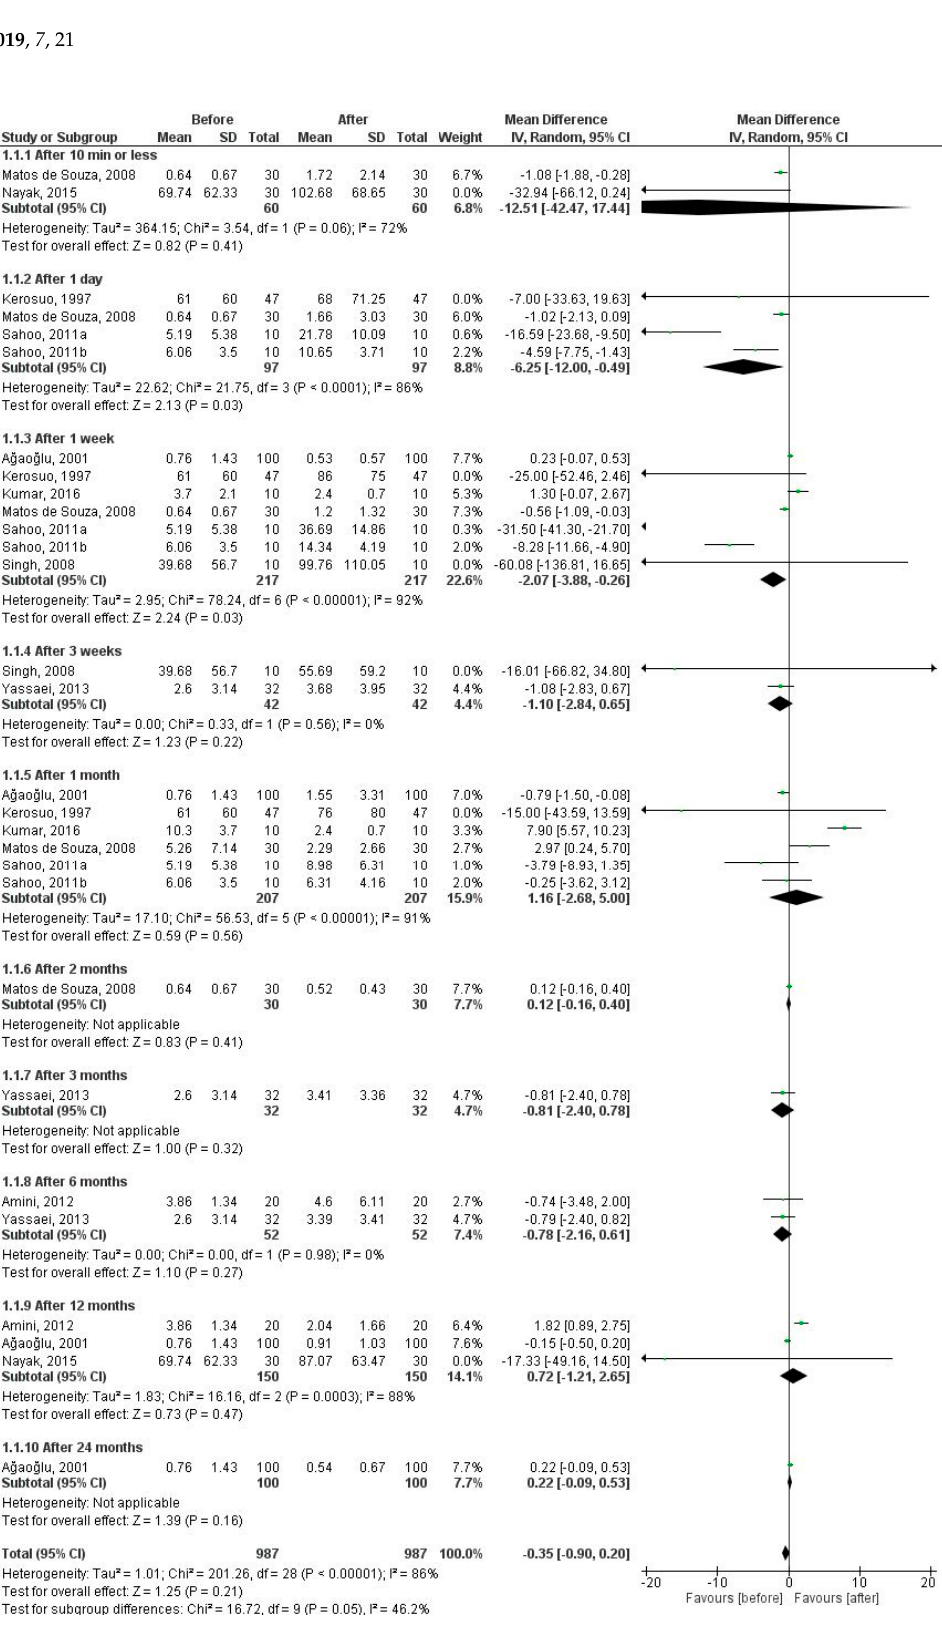
Figure 3. Forest plot of the random effect of salivary chromium levels in patients under fixed orthodontic treatment (before versus after treatment).